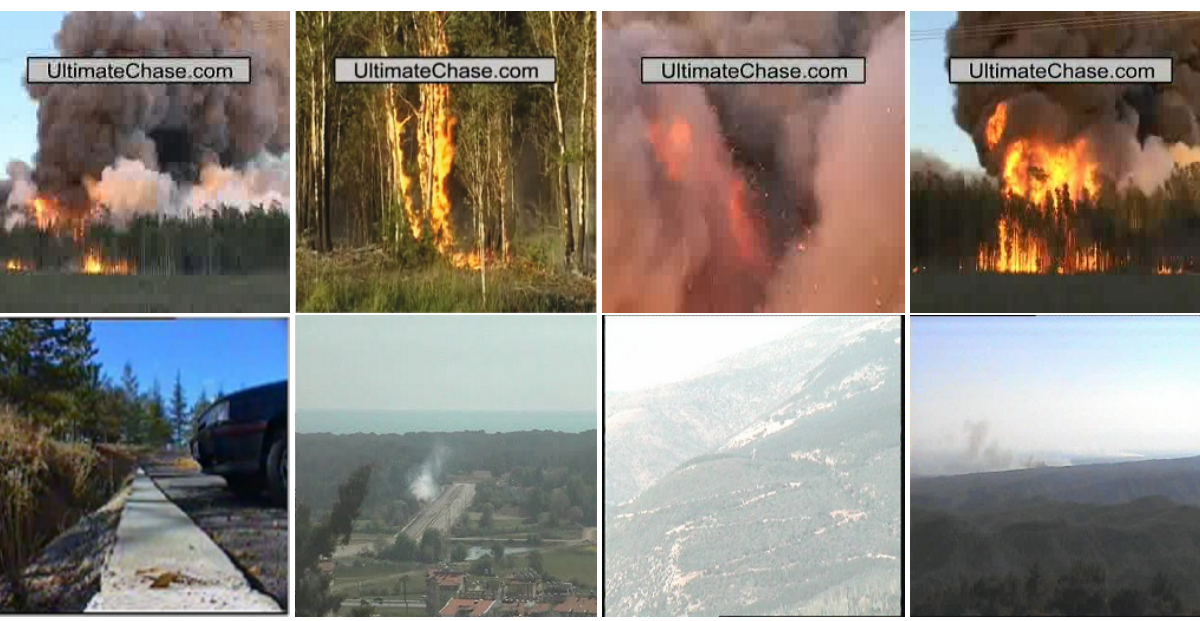
Figure 11. Examples from the VisiFire